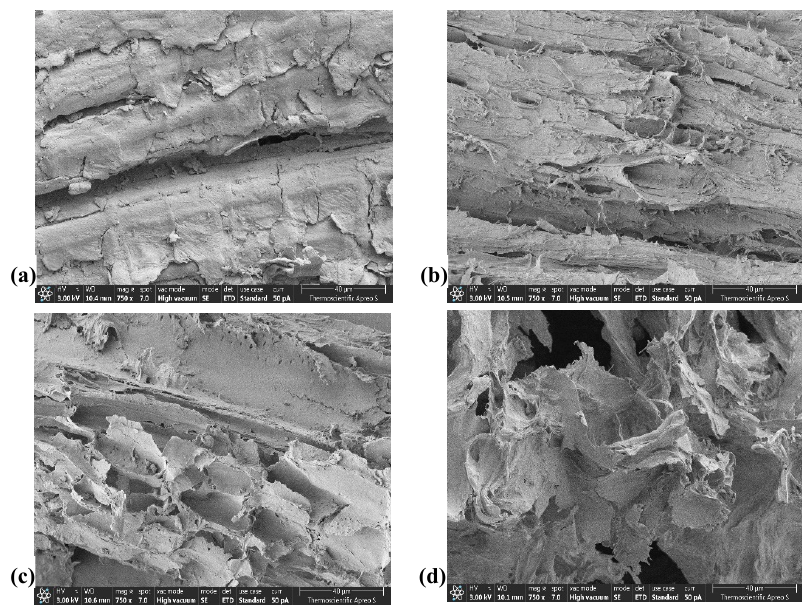
Figure 4a – e for bark fiber and Figure 5a – e for core fiber. Untreated biomass revealed a typical uniform, compacted surface, organized, and stiff fibril structure formed in bundles of intact on the surface of bark and core fibers (Figures 4a and 5a, respectively). After both types of raw biomass were treated with different amounts of PA, the surface structure of each untreated biomass was remarkably altered and subsequently cracked, displaying long rod-shaped vessels. In addition, the fibers inside the intact structures of both samples eventually split, causing them to become highly disordered. (Figures 4b – e and 5b – e).